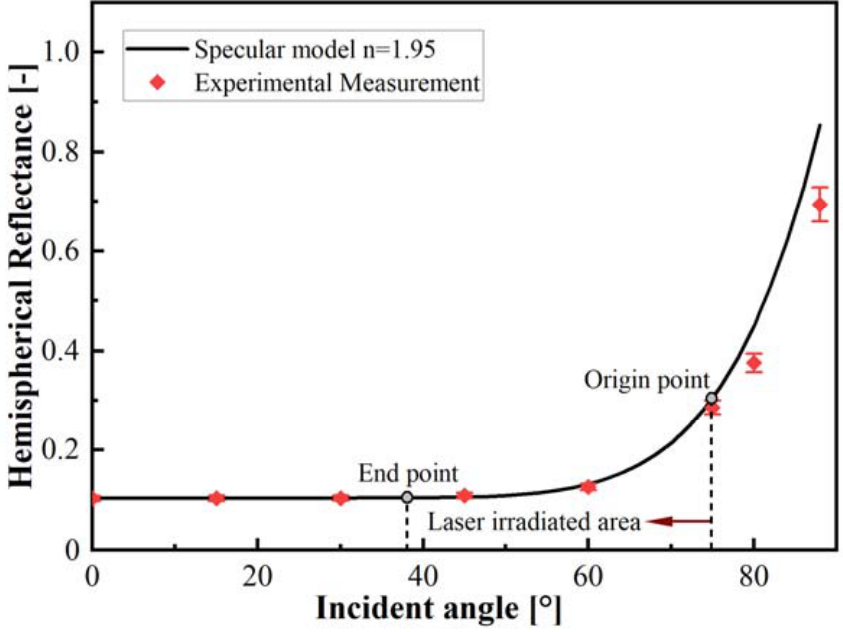
Figure 6. Angular dependence of reflectance for CF/PPEK composite.